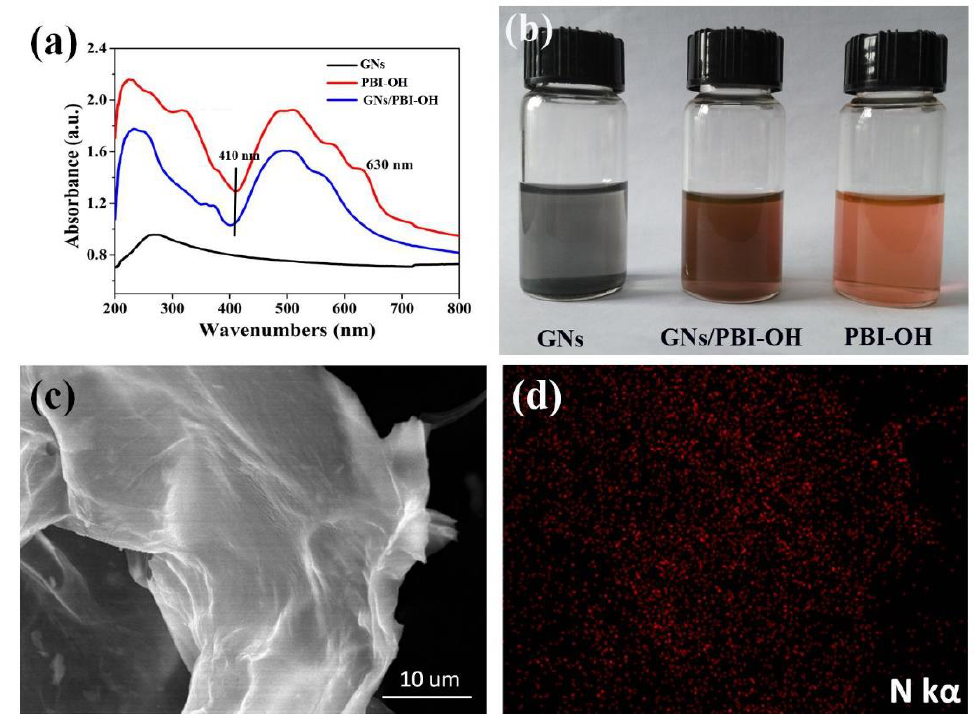
Figure 4. ( a ) UV-Vis spectra of GNs, PBI-OH and GNs/PBI-OH; ( b ) Solubility of GNs, PBI-OH and GNs/PBI-OH in DMF; ( c ) The scanning electron microscope (SEM) image of GNs/PBI-OH; and ( d ) Elemental mapping of N is shown in red.